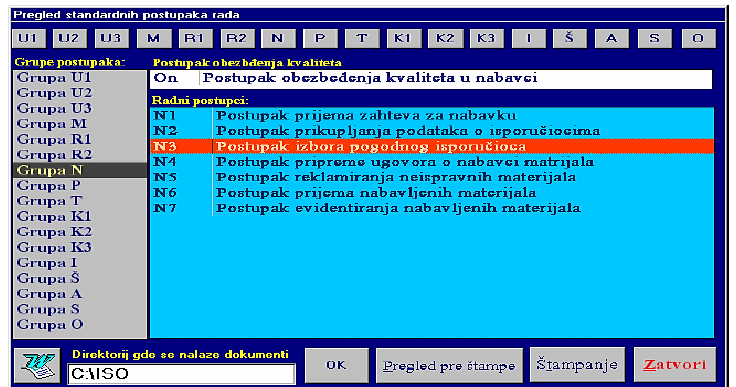
Figure 7 – Example of the window ”searching” according to the group of processes and the providing